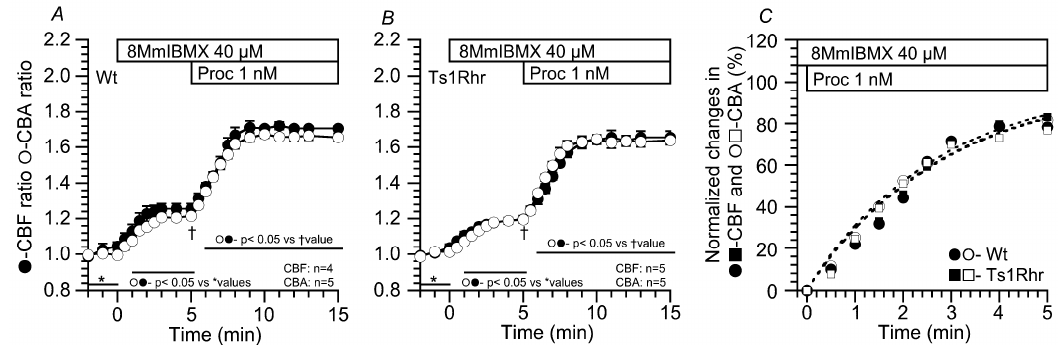
Table 4. Effects of procaterol stimulation on CBF and CBA ratio in the presence of 8MmIBMX and calmidazolium (Calmidaz). Figure 4. Effects of 8MmIBMX on the procaterol-stimulated CBF and CBA increases. The addition of